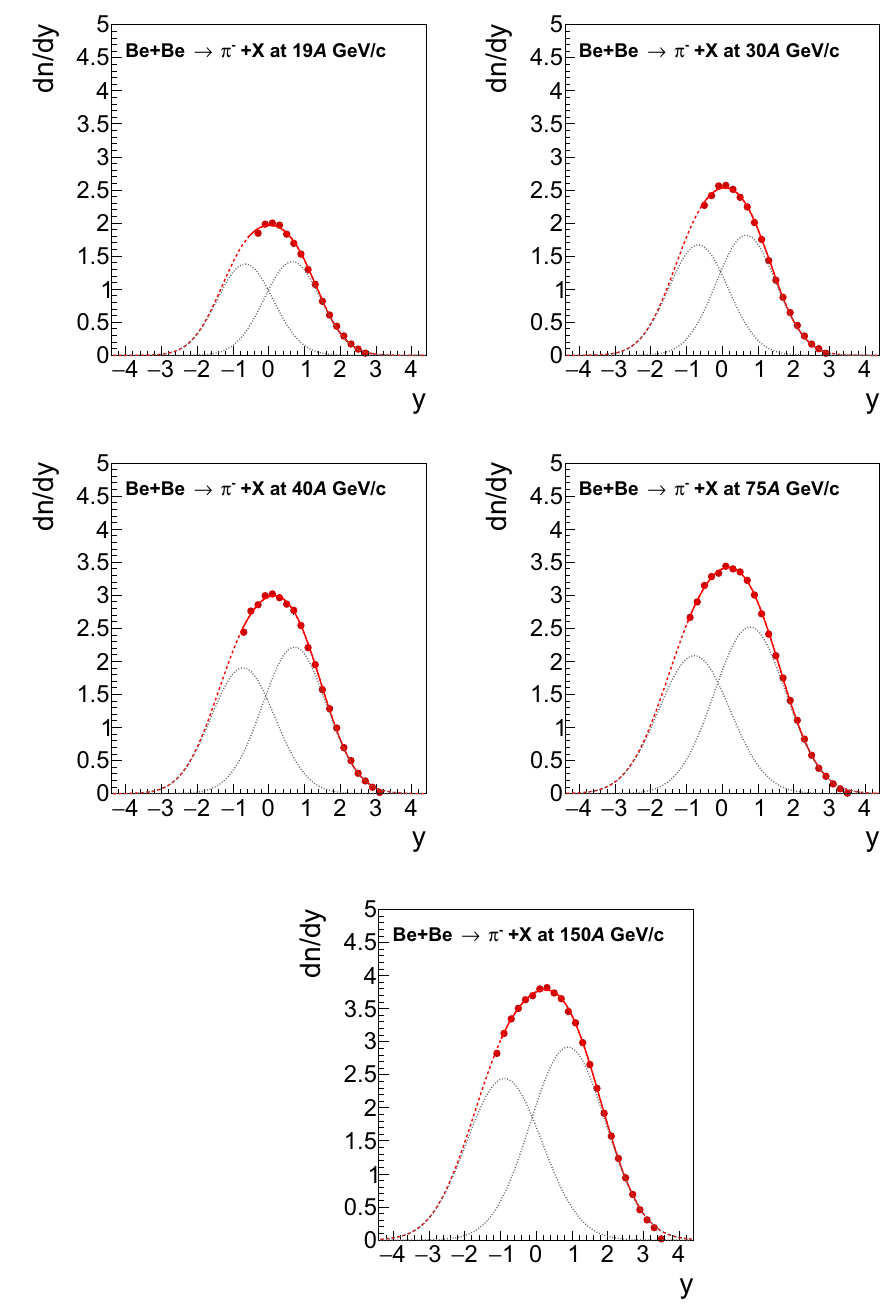
Fig. 15 Rapidity distributions of negatively charged pions in central Be + Be collisions at the SPS energies. The parametrization of the spectra by Eq. 5 is shown. The solid line shows the fitted function in the range of the fit, and the red dashed line depicts the extrapolation of the fitted function. The two Gaussian functions constituting the fitted function are represented by the black dashed lines